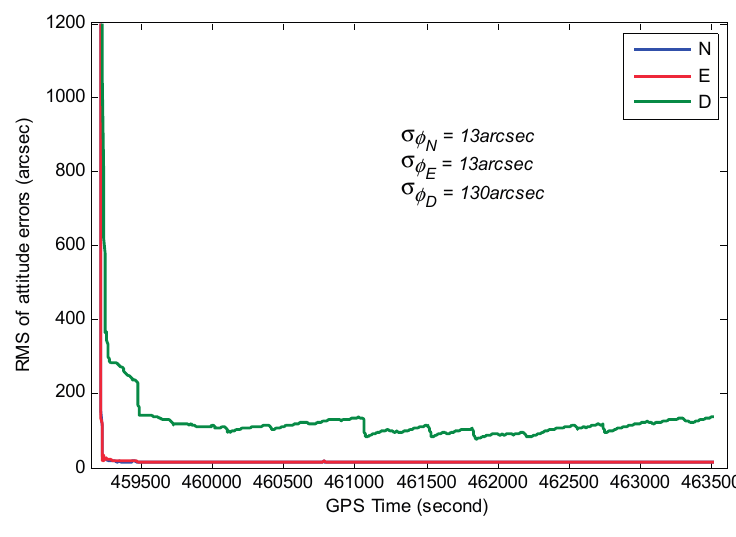
Figure 19. RMS of the estimated attitude errors.